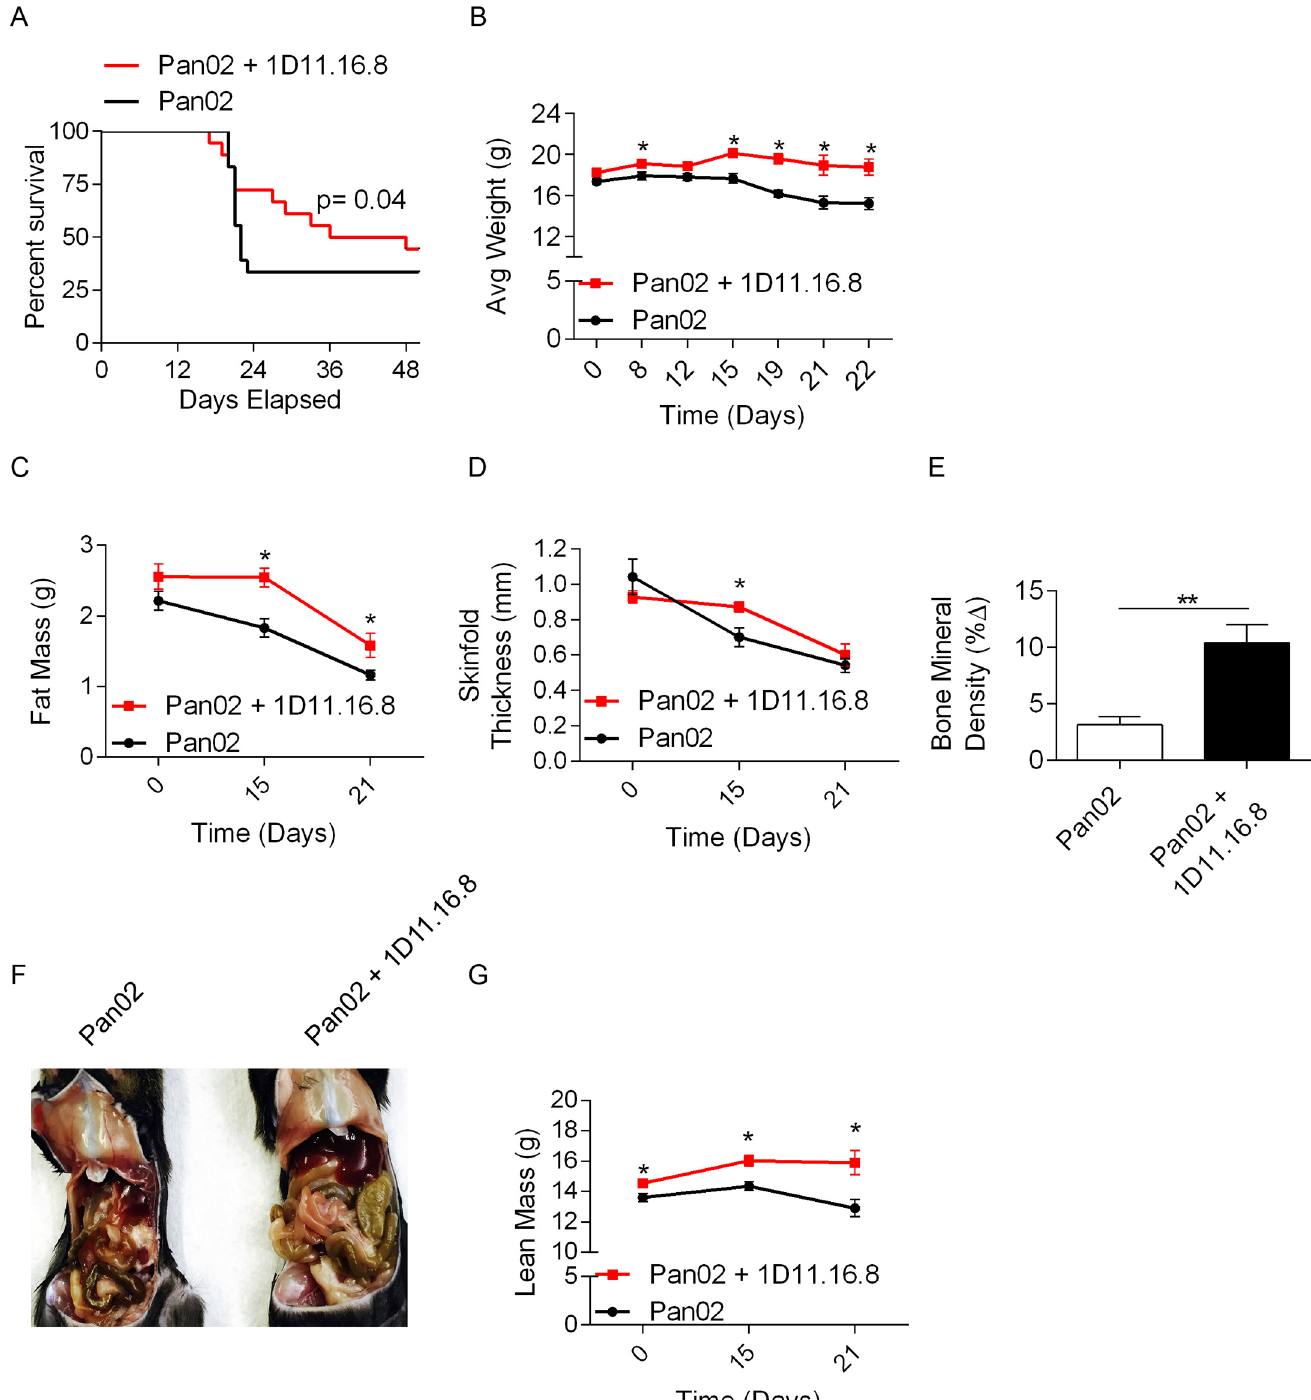
Fig 6. TGF- β inhibition improves overall survival and body composition in pancreatic cancer cachexia. (A) Mice were treated with Pan02 or Pan02 + 11D1.16.8 and tested for survival using Kaplan-Meier analysis. (B) Cohorts of mice were also tested for weight change, and changes in (C) fat mass, (D) skinfold thickness, or (E) bone mineral density (n = 10/group; * p < 0.05, ** p < 0.01). (F) Mice were treated with Pan02 or Pan02 + 11D1.16.8 and were evaluated for gross loss of lean body mass. (G) Cohorts of mice were also tested for change in lean body mass (n = 10/group; * p < 0.05).